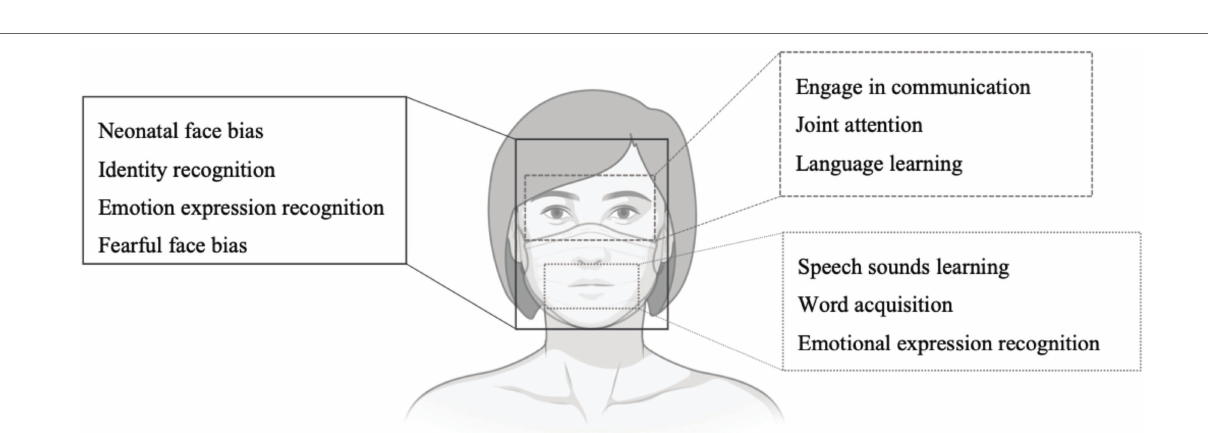
FIGURE 3 | Psychological processes linked to face processing. Created with